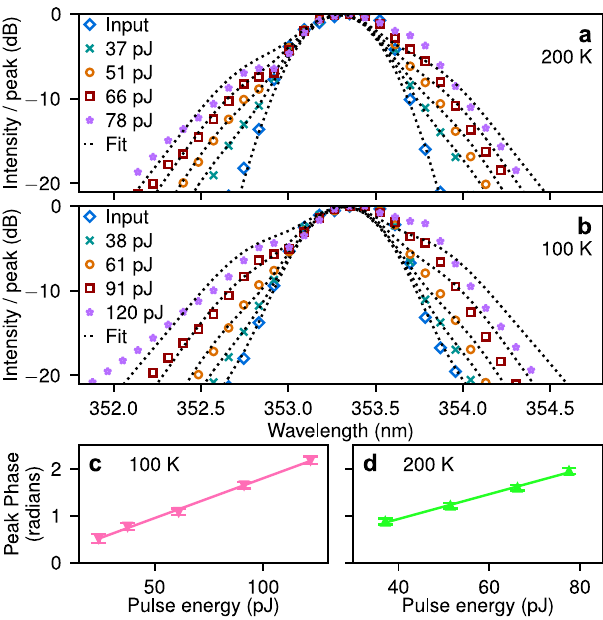
Fig. 5 Spectral broadening in the low power limit. a , b Comparison of experimental spectra (points) and best fi t of SPM model spectra (dotted lines) for two temperatures and several pulse energies. c , d Peak phase from the SPM fi ts in ( b ) and ( a ). Error bars give the uncertainty in peak phase obtained from the least-squares fi tting procedure (±2 standard deviations). Solid lines show the linear best fi